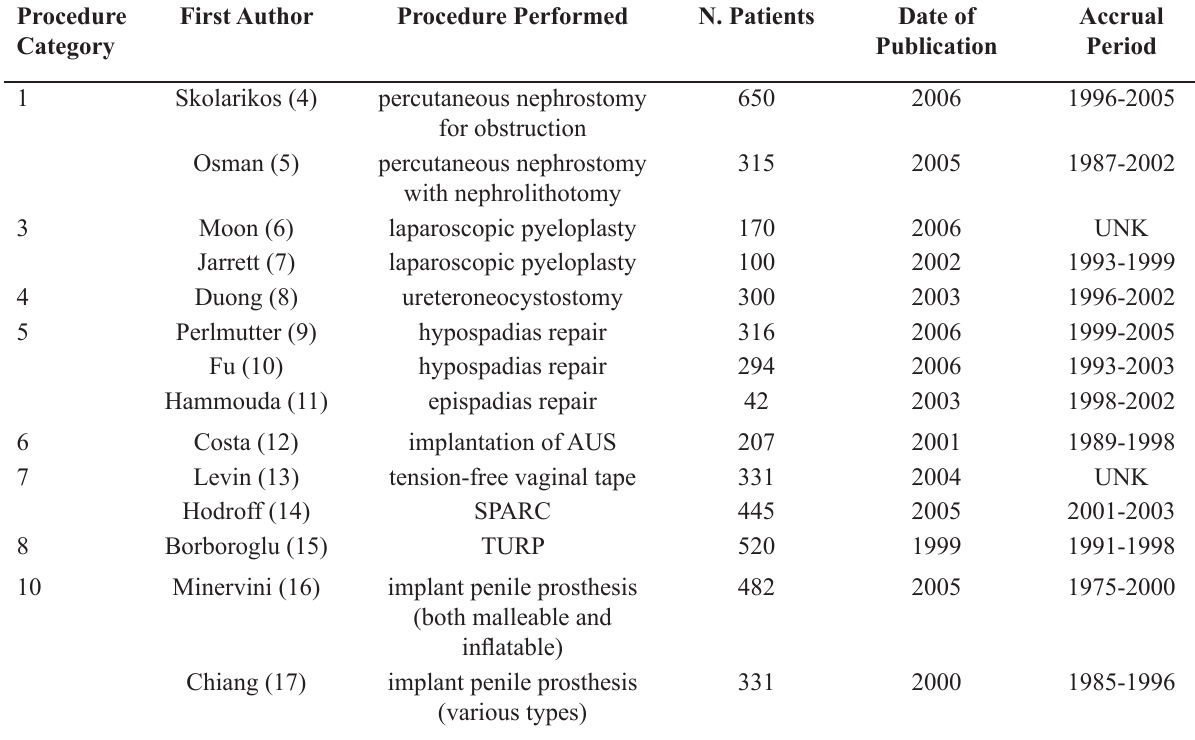
Table 2 – List of case series from our literature